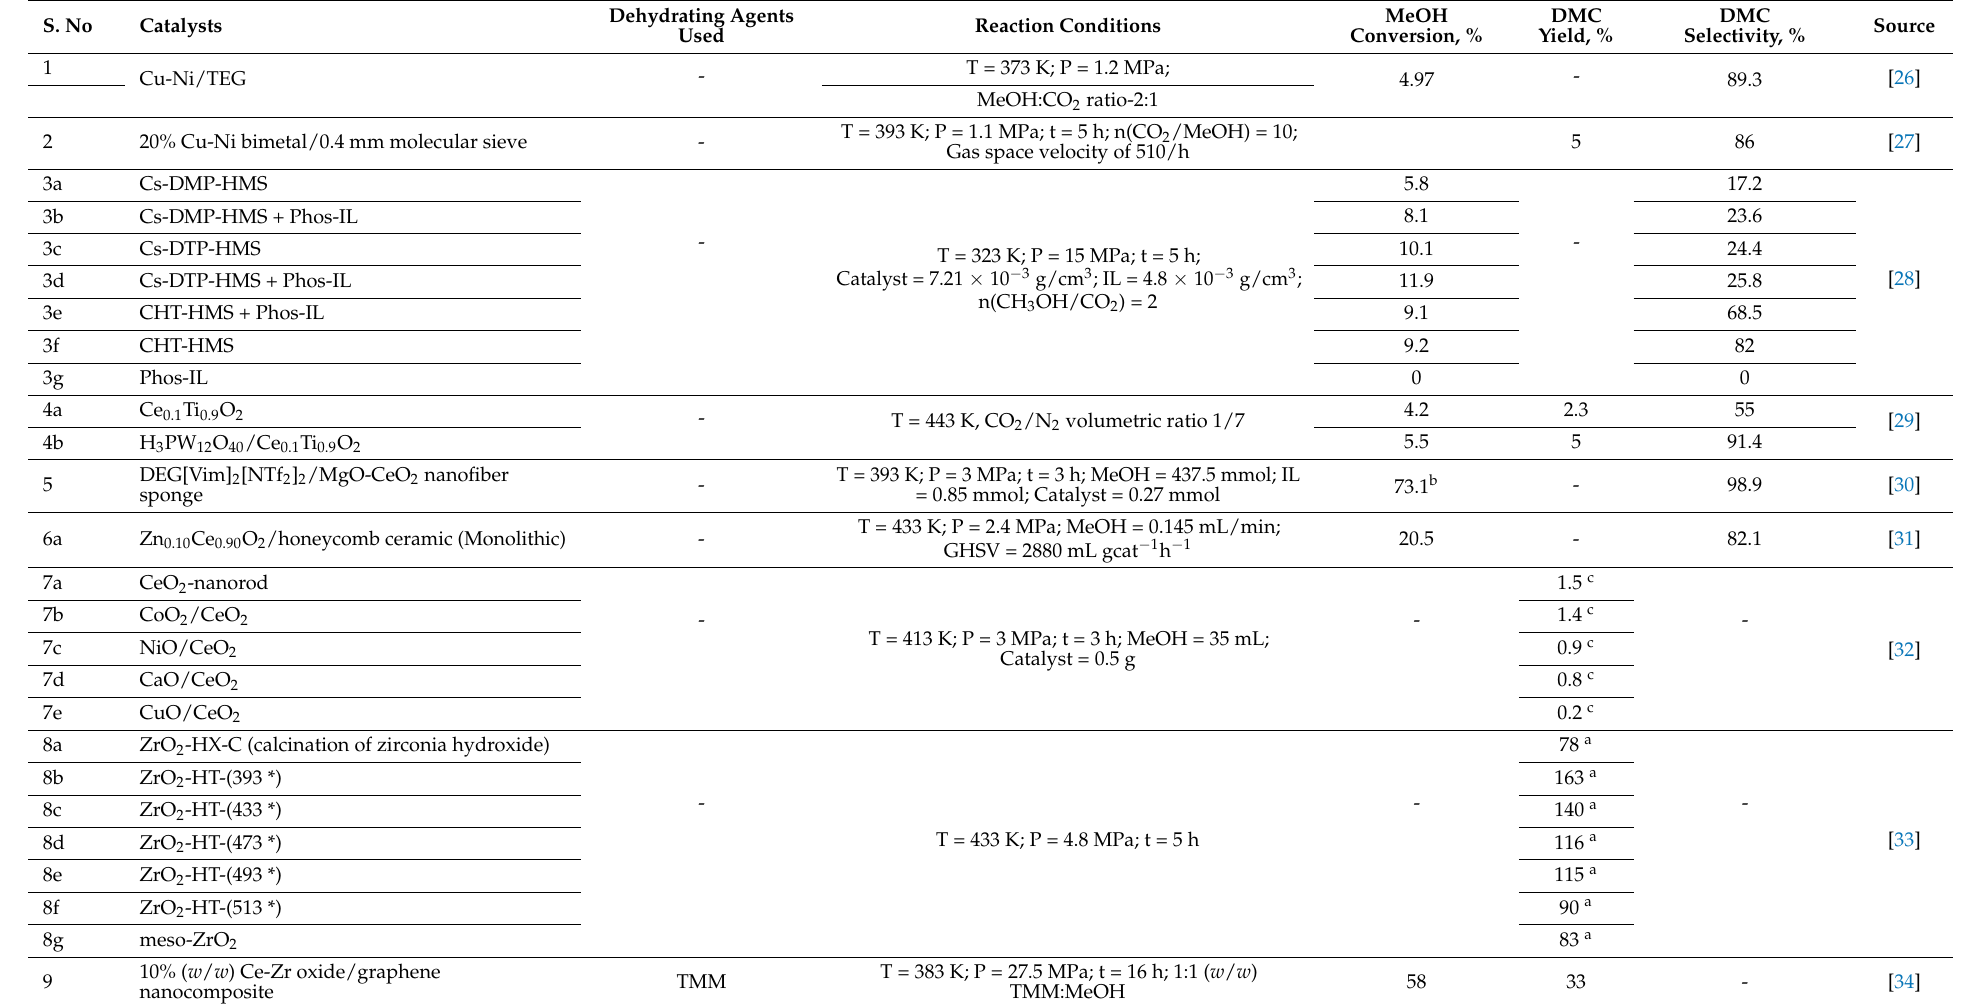
Table 1. Literature review of the catalysts used for the direct conversion of CO 2 to